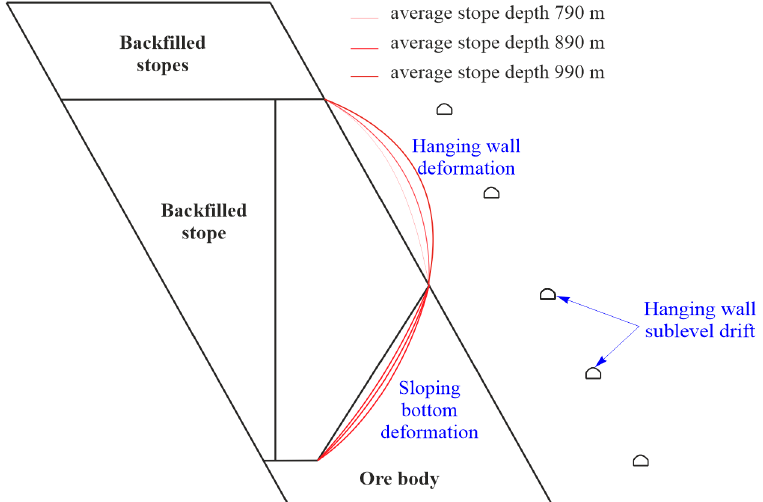
Figure 9. Areas of deformations development in the rocks of the hanging wall and sloping bottom with an increase in the depth of mining.